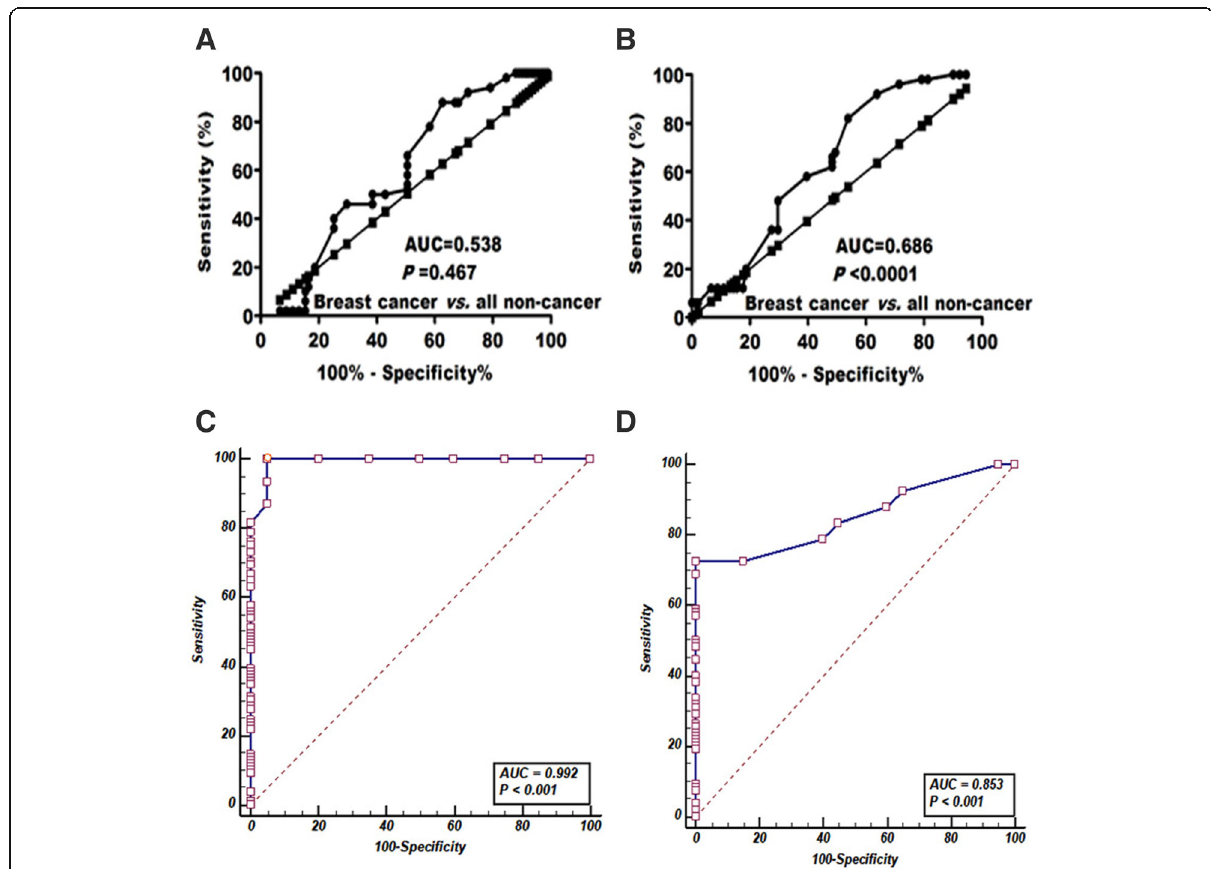
Fig. 2 Receiver operating characteristic curve for ( a ) CEA, ( b ) CA15.3, ( c ) methylated PTEN, and d methylated SMAD4 to distinguish patients with breast cancer from non-cancer (healthy and benign combined)